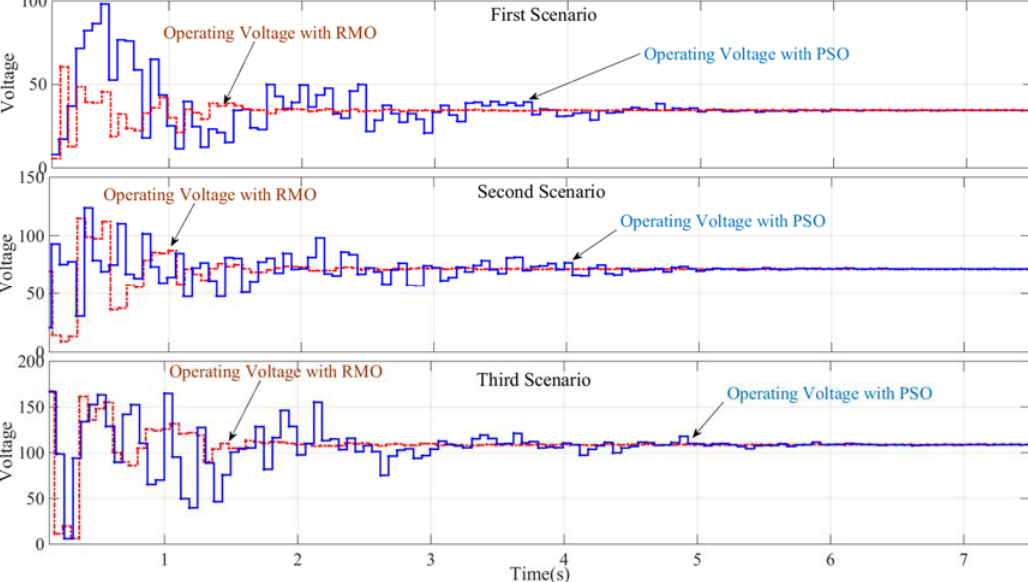
Figure 14. The output voltage fluctuation of the PV system controlled by the RMO method versus PSO technique for three shading conditions.